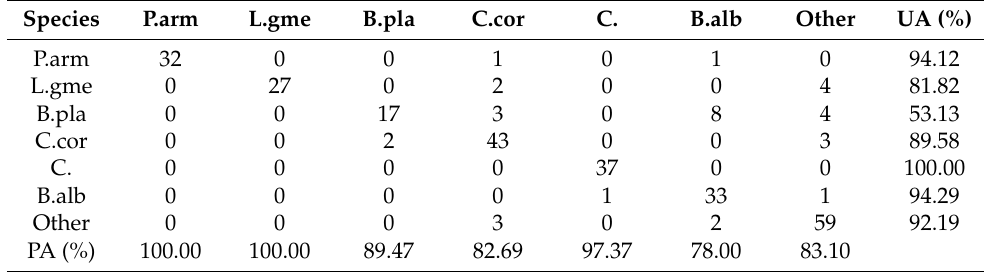
Table 10. Classification confusion matrix of tree species at altitude of 1600 m based on